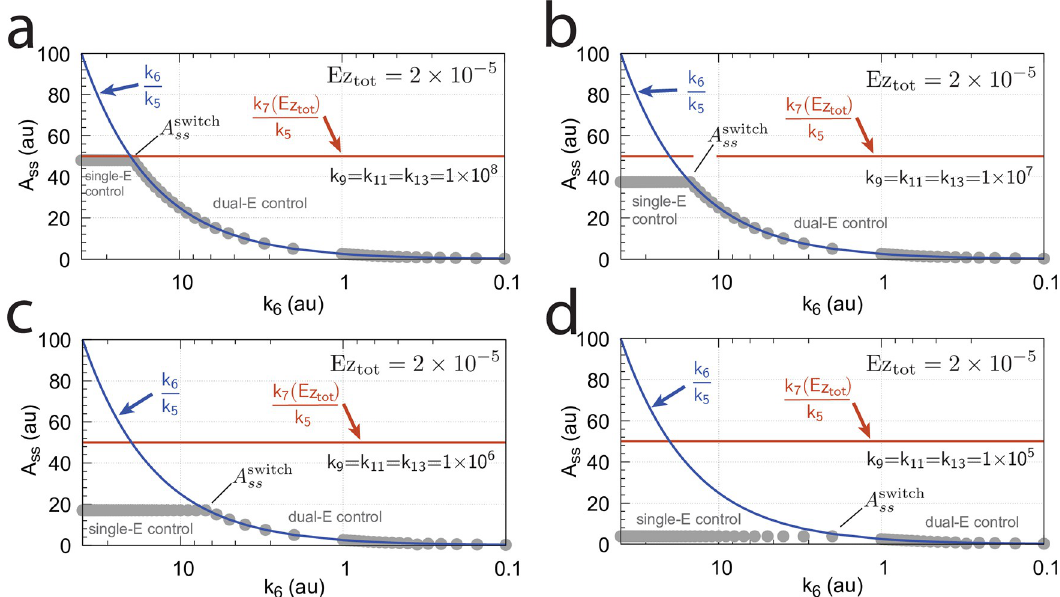
Fig 17. Change of the switch point between dual-E and single-E control with decreasing values of k 9 , k 11 , and k 13 . (a)